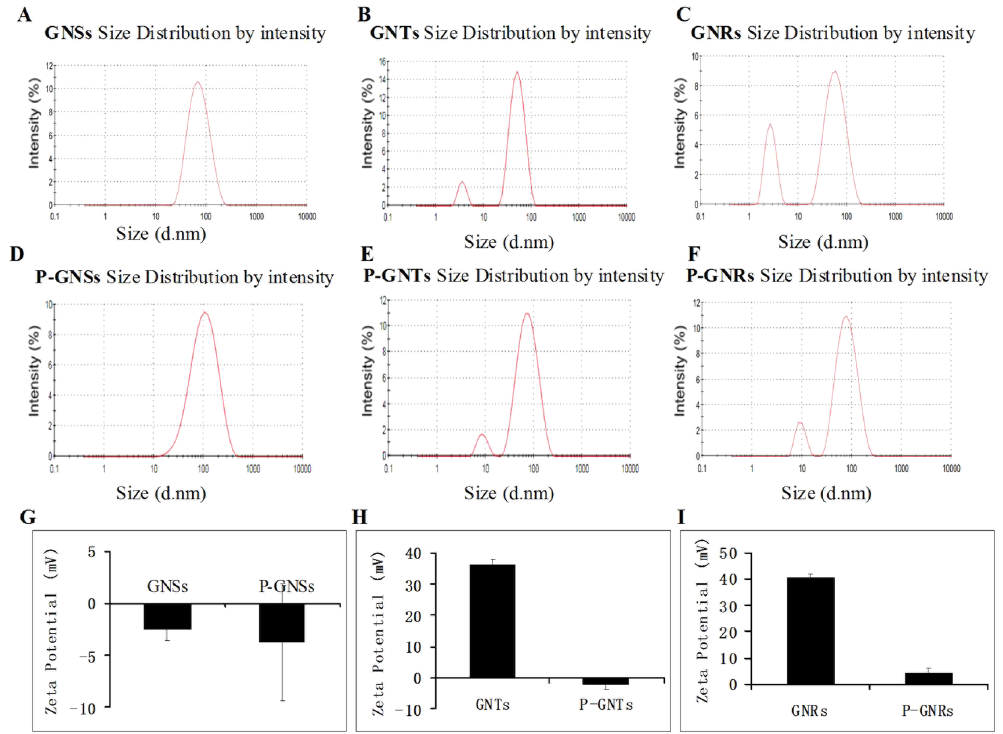
Figure 3. Size and zeta potential of GNPs and P-GNPs: Size of GNSs, GNTs, GNRs( A , B , C ), Size of P-GNSs, P-GNTs, P-GNRs( D , E , F ), Zeta potential of GNSs and P-GNSs( G ), GNTs and P-GNTs ( H ), GNRs and P-GNRs ( I ).